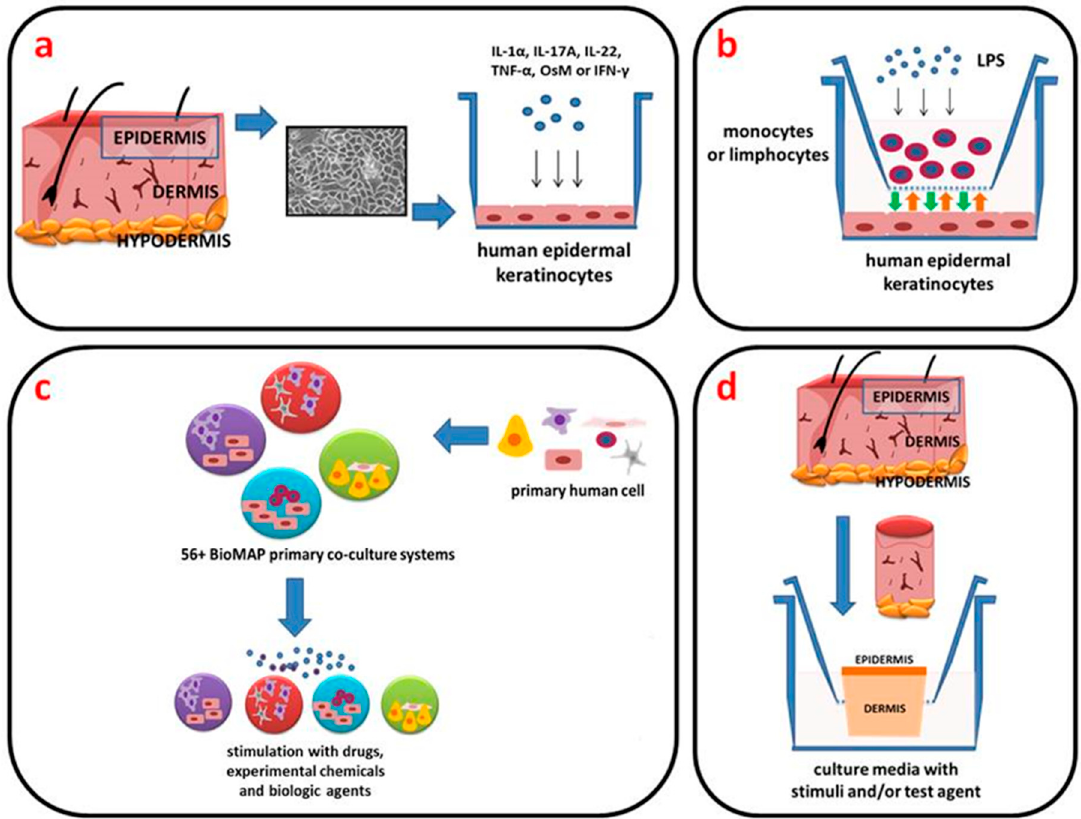
Figure 2. Engineered Ps models. ( a ) The two-dimensional (2D) engineered skin psoriatic cell model; ( b ) The co-culture system; ( c ) The biologically multiplexed activity profiling (BioMAP) system; ( d ) The reconstituted human epidermal model (3D).